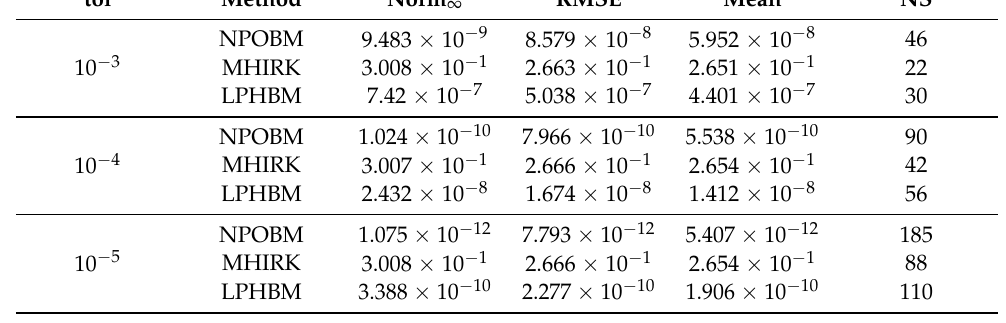
Table 16. Numerical results for Problem 4 with adaptive step-size approach while ∆ x ini = 10 − 6 . tol